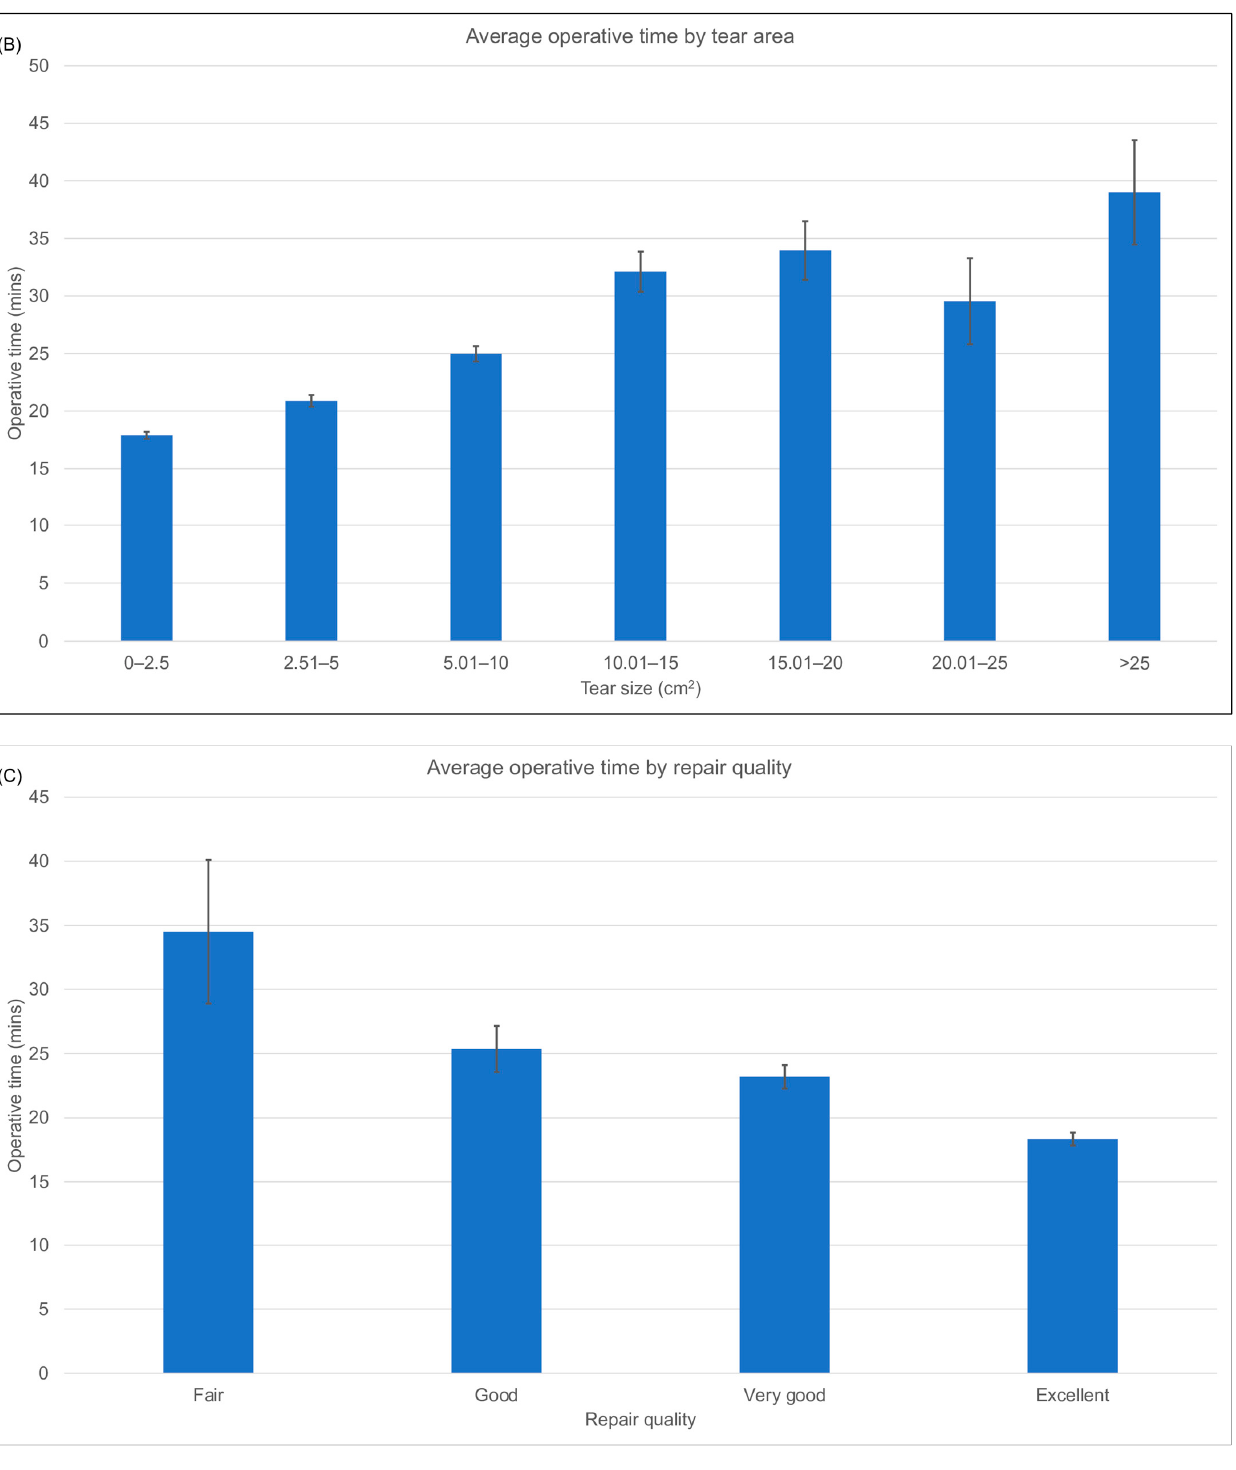
Figure 4. ( A ) Average operative time against number of anchors utilised in repair. Error bars indicate SEMs. Use of more anchors increased average operative time. ( B ) Average operative time against tear size. Error bars indicate SEMs. Increased tear size was associated with increased operative time. ( C ) Average operative time against repair quality. Error bars indicate SEMs. Higher repair quality was associated with reduced operative time.